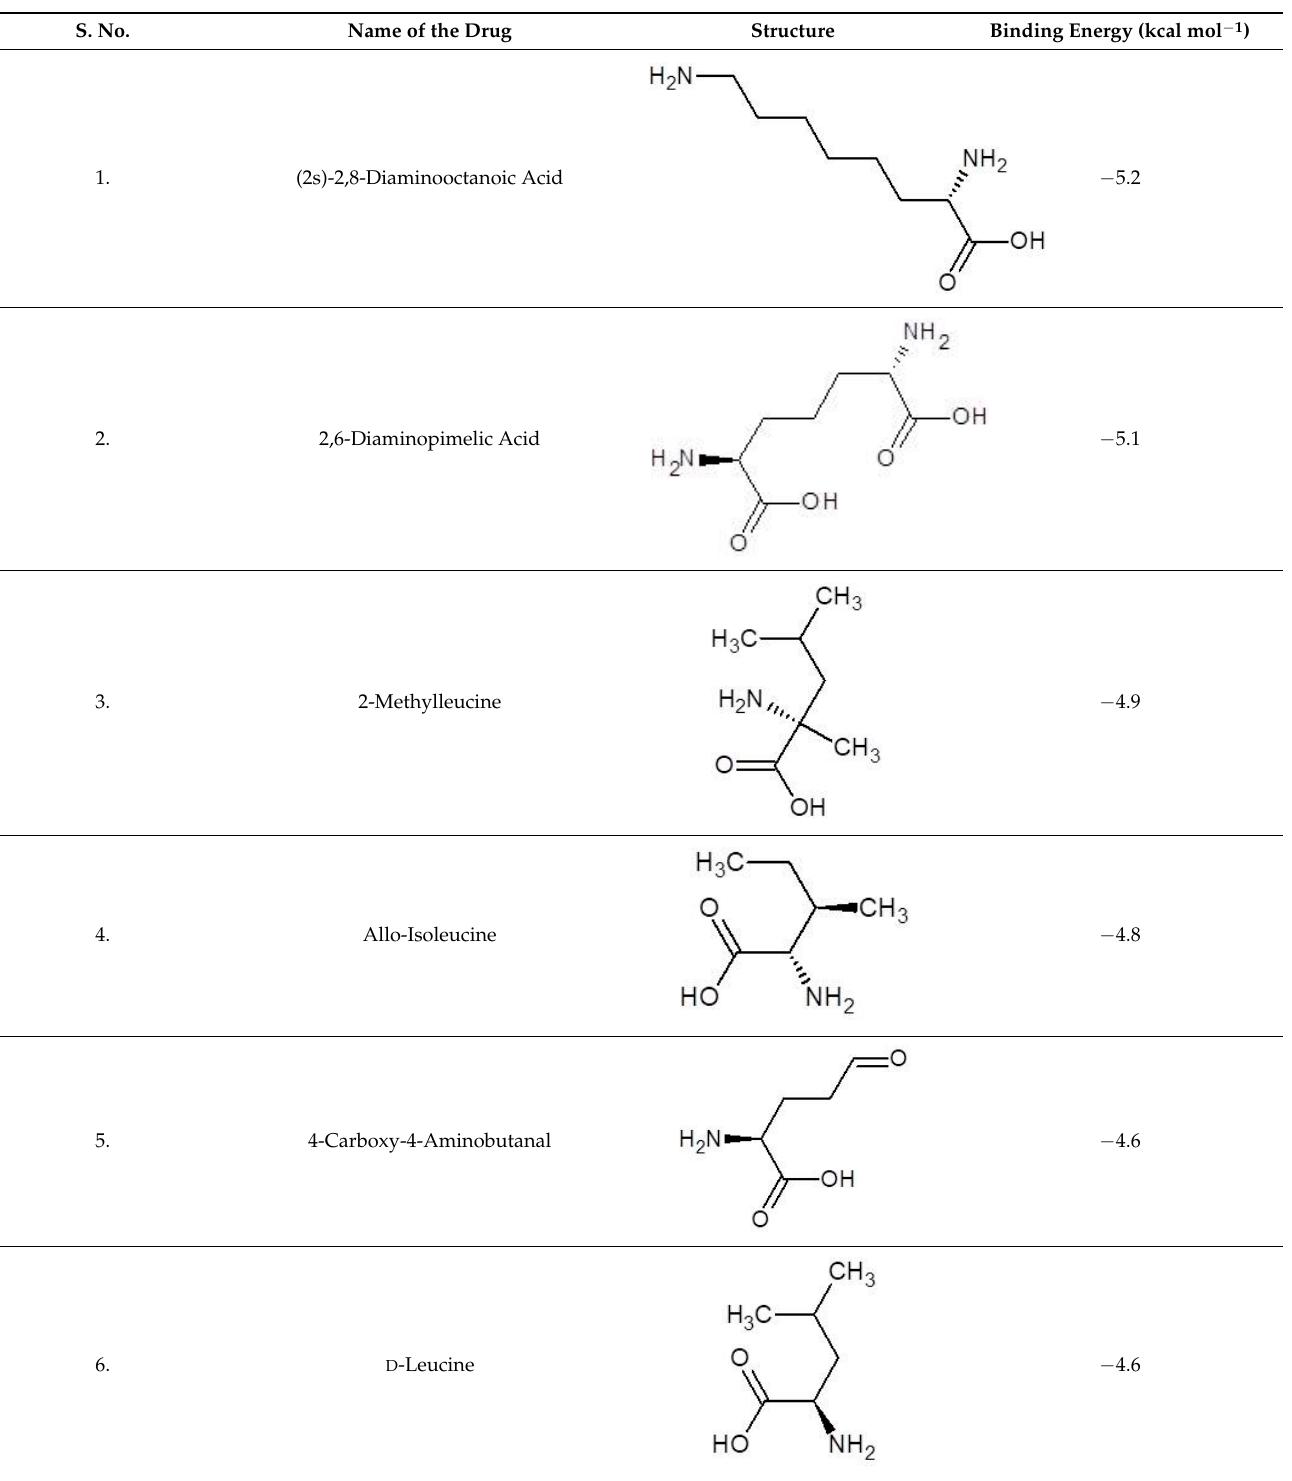
Table 1. Structures and binding energies of drugs that are structurally similar to L -Ornithine.